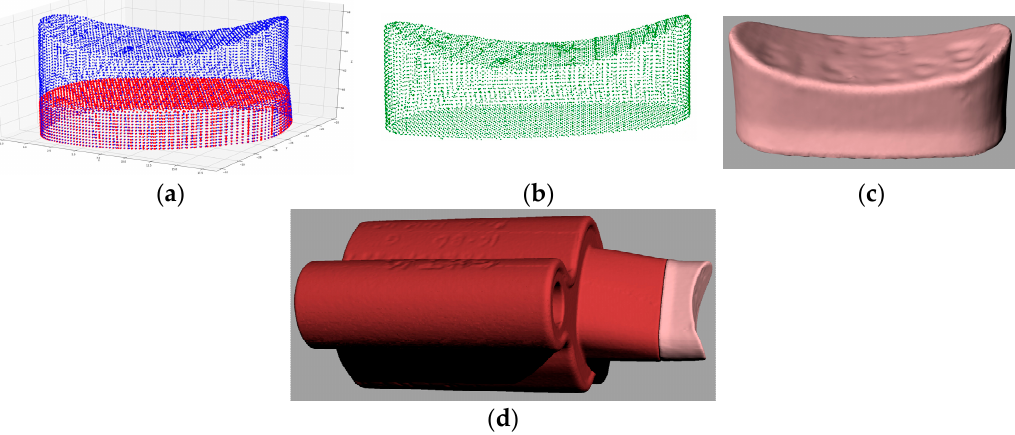
Figure 15. Repair volume reconstruction. ( a ) Intersections of rays with nominal and damaged models; ( b ) extracted points; ( c ) model of the extracted points; ( d ) damaged geometry on the damaged model.